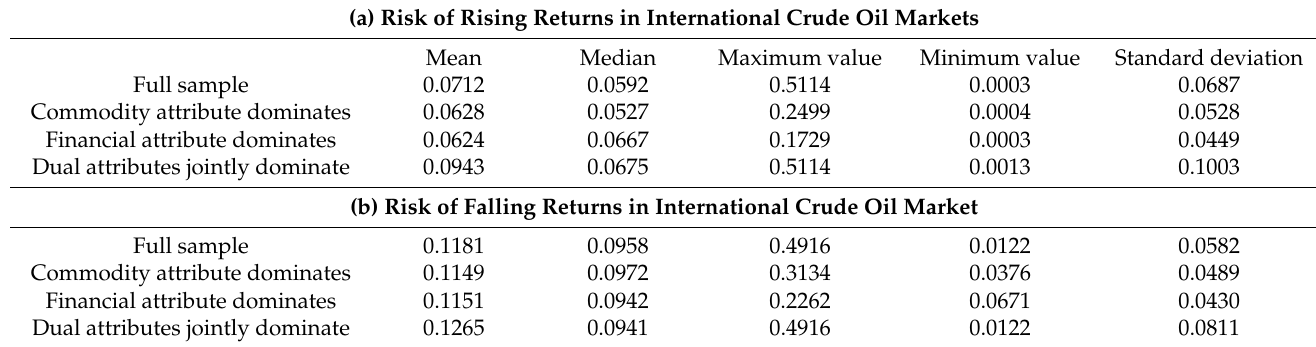
Figure 5. The risk evolution of the international crude oil market under the condition of returns rise and fall. Note:( a ) displays the risk evolution under the rising returns in the international crude oil market; ( b ) shows the risk evolution under the falling returns in the international crude oil market. B is the period jointly dominated by two attributes of oil; C is the period dominated by oil commodity attribute; F is the period dominated by oil finance attribute. Table 2. Descriptive analysis of risk evolution in international crude oil market under different returns